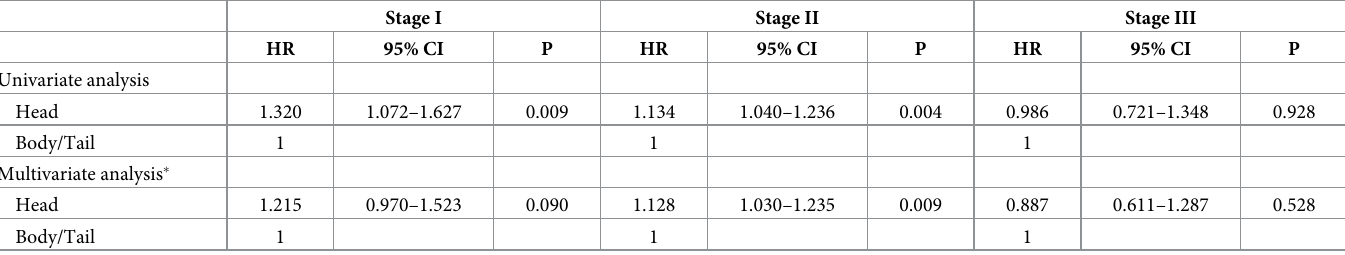
Table 5. Univariate and multivariate analysis of CSS in patients who underwent curative intent surgery for pancreatic cancer by